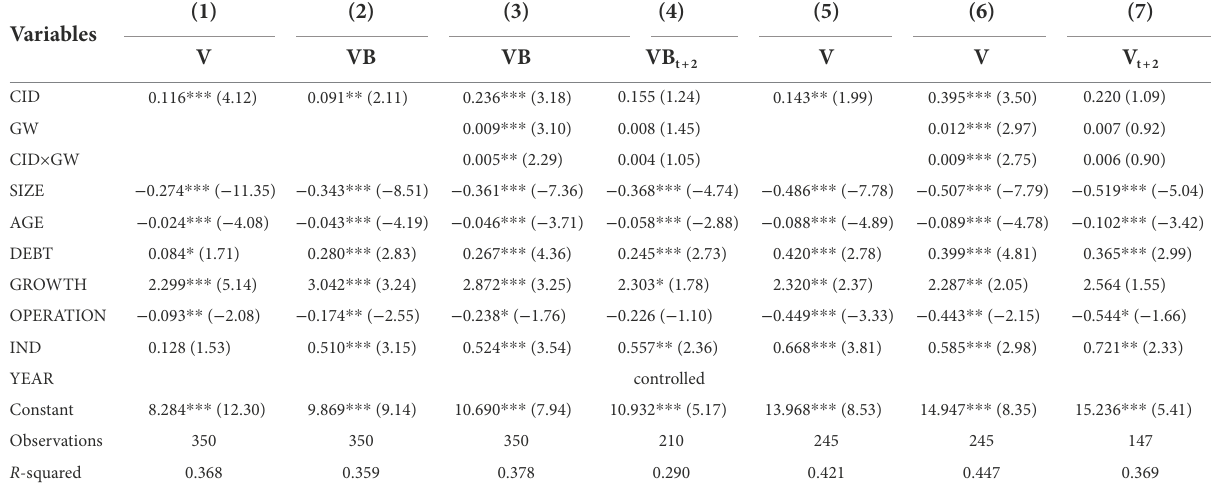
TABLE 14 Robustness